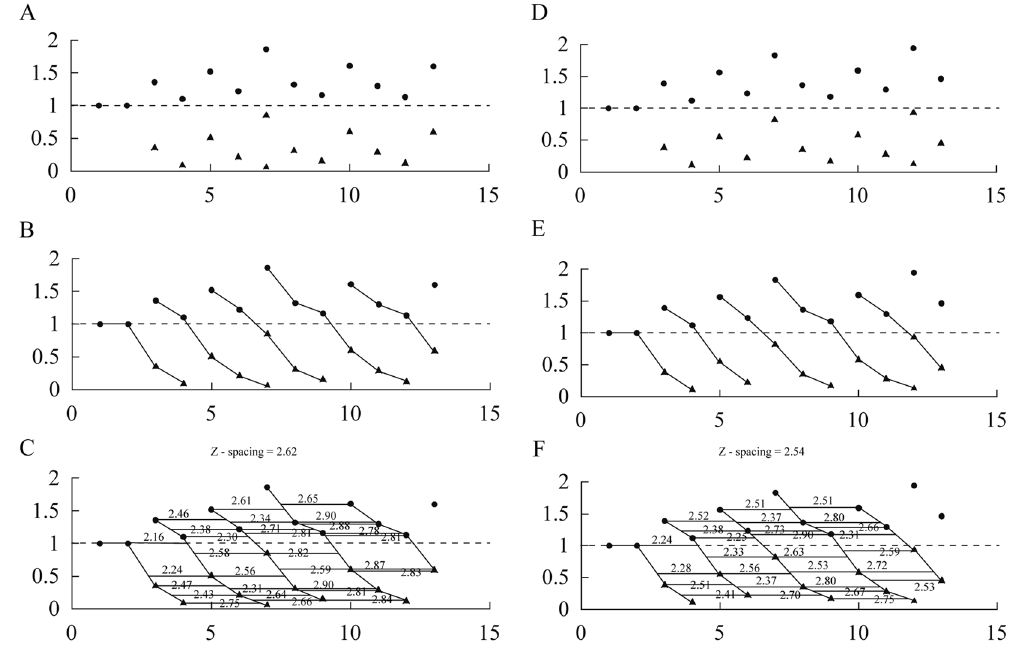
Figure 7. Quantification of upper jaw dentition in IVPP V12738. X-axis is the tooth position, Y-axis is the tooth replacement index. ( A–C ) are upper left side of jaw, ( D–F ) are upper right side of jaw. A and D: Replacement index. B and E: Zahnreihen. C and F: Z-Spacing. Dark circles representing the replacement index of functional teeth of upper jaw, triangle representing the replacement index of replacement teeth of upper jaw.